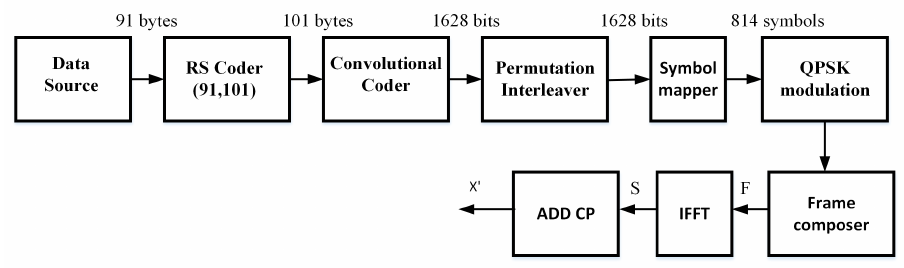
Figure 3. LDACS transmitter block